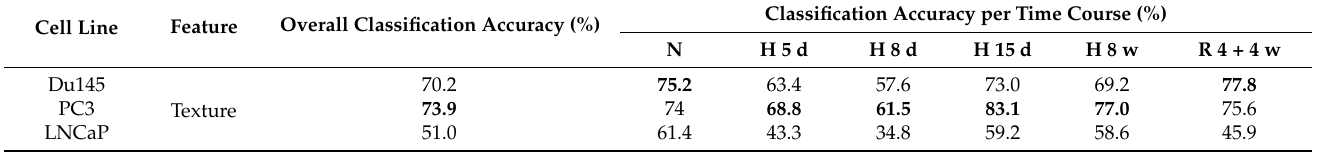
Table 2. Machine-learning classification of individual experimental timepoints within each of the three cell lines (Du145, PC3, LNCaP). The different conditions are normoxia (N), acute hypoxia (5 d, 8 d, 15 d—days 5, 8 and 15), chronic hypoxia (8 w—8 weeks) and recovery (4 + 4 w—4 weeks hypoxia + 4 weeks normoxia). Classification was performed using texture cytoskeletal features and aquaporin distribution within the cytoskeleton as predictors. Highest accuracy is shown in bold. Cell